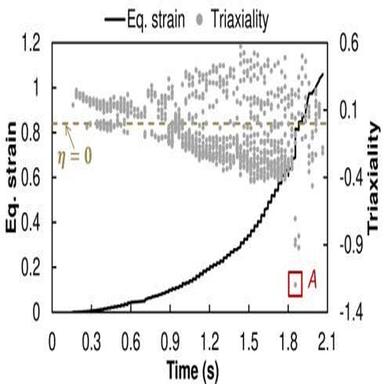
Evolution of equivalent strain and stress triaxiality within the midsensor. Only the values corresponding to a non-zero strain rate are shown. Point A corresponds to the most severe compressive state experienced by this sensor.